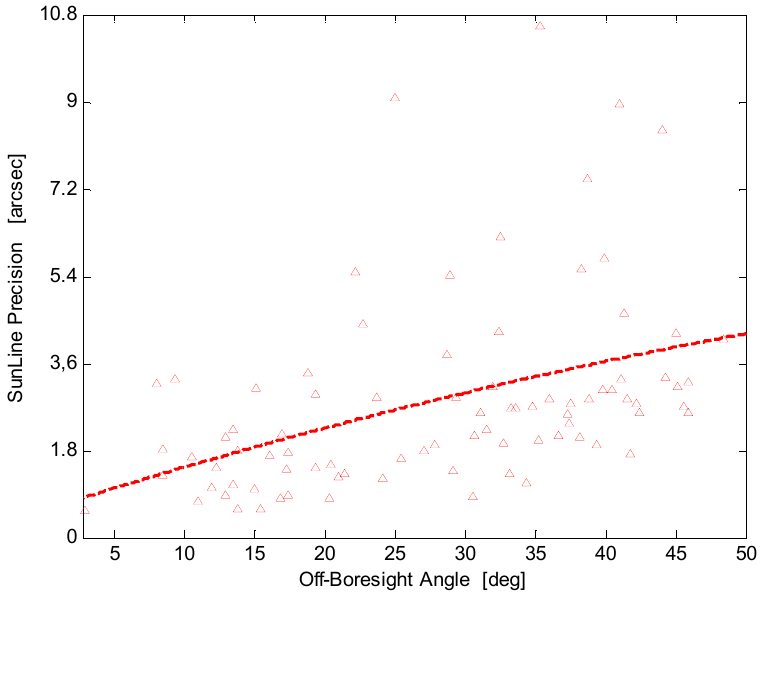
Figure 13. Sun-line precision versus the off-boresight angle for the enhanced